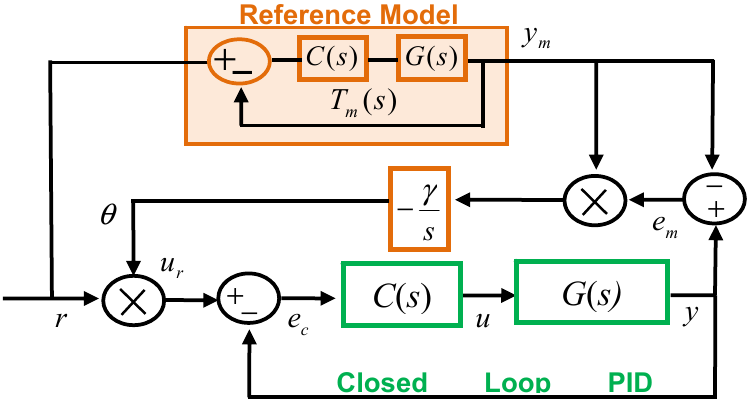
Figure 2. Block diagram of the ML-MR PID-MIT control structure and a solution for numerical realization of reference models.